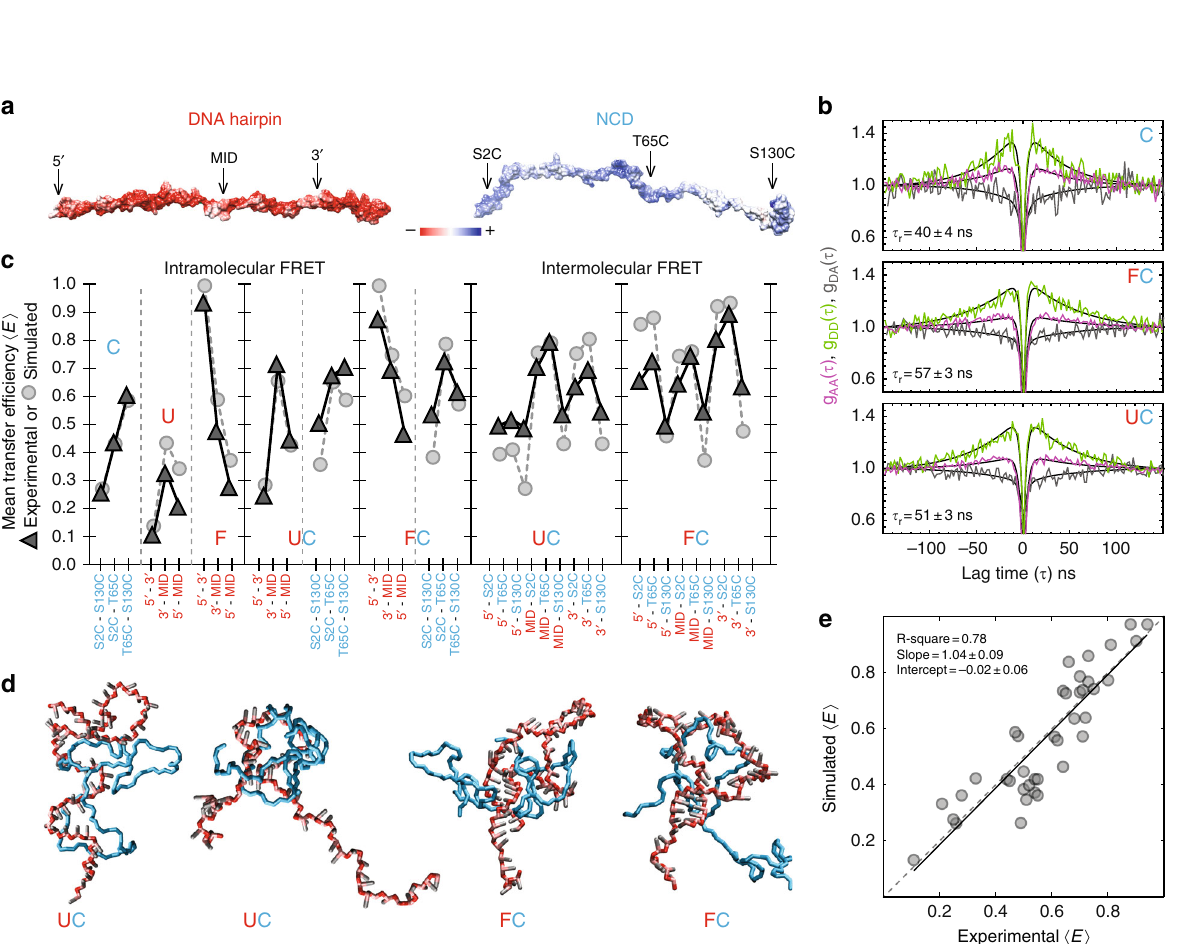
Fig. 3 Structural properties of chaperone-hairpin complex. a Molecular surface representations of the binding partners colored by electrostatic potential (red, negative; blue, positive). Arrows indicate the approximate location of labeling sites. b Donor-donor (light green), acceptor-acceptor (magenta), and donor-acceptor (gray) fl uorescence correlation functions for FRET-labeled NCD S2C-T65C in isolation (top), bound to the hairpin (middle), and bound to the folding-incompetent hairpin (bottom). Solid black lines are global fi ts of the three respective correlation functions, which are used to determine the recon fi guration times, τ r , of the chaperone. c Mean transfer ef fi ciencies for all labeling pairs from the mapping experiment (triangles) at 30 mM PB pH 7.0 and the coarse-grained molecular simulations (circles). Mean values are provided in the Source Data fi le. Labeling positions in the chaperone and the hairpin are shown in cyan and red, respectively. The uncertainties associated with transfer ef fi ciency values are ~0.01 based on multiple simulations and ~0.03 for the experiments (error dominated by instrument calibration). d Molecular representations of the disordered nucleic acid-chaperone complex from the simulations (see Supplementary Movies 1 and 2); color code as in Fig. 1a. e Correlation between experimental and simulated mean transfer ef fi ciencies. The dashed gray line is the identity line, the solid black line is a linear regression